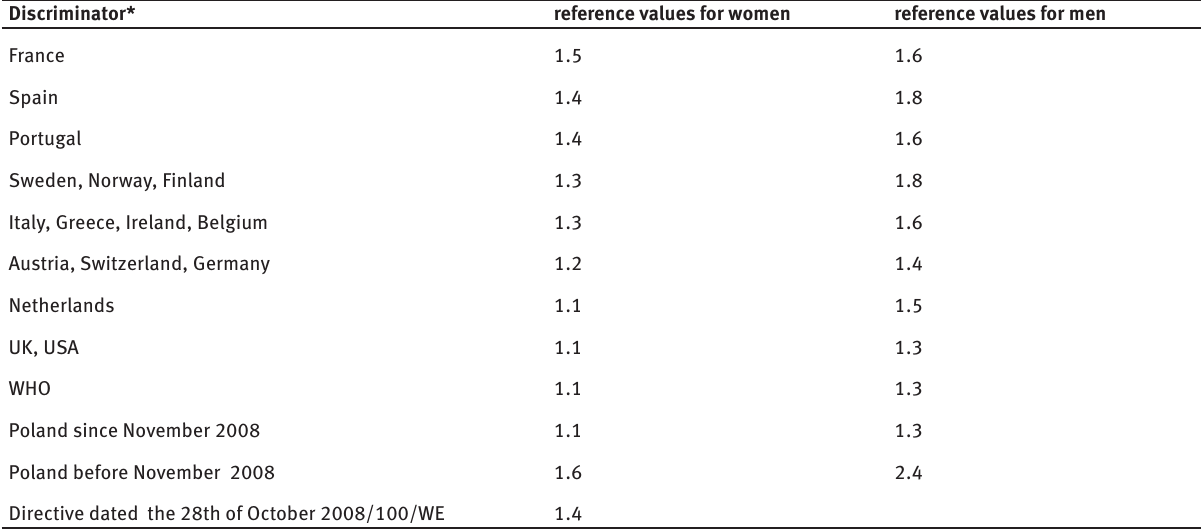
Table 3: The daily consumption reference values for riboflavin in various regions of the world.